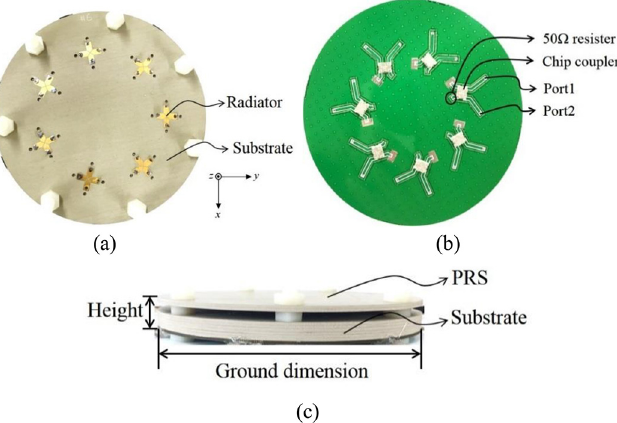
Fig. 15. Photographs of the fabricated CRPA array. (a) Top view before mounting superstrate, (b) bottom view, and (c) side